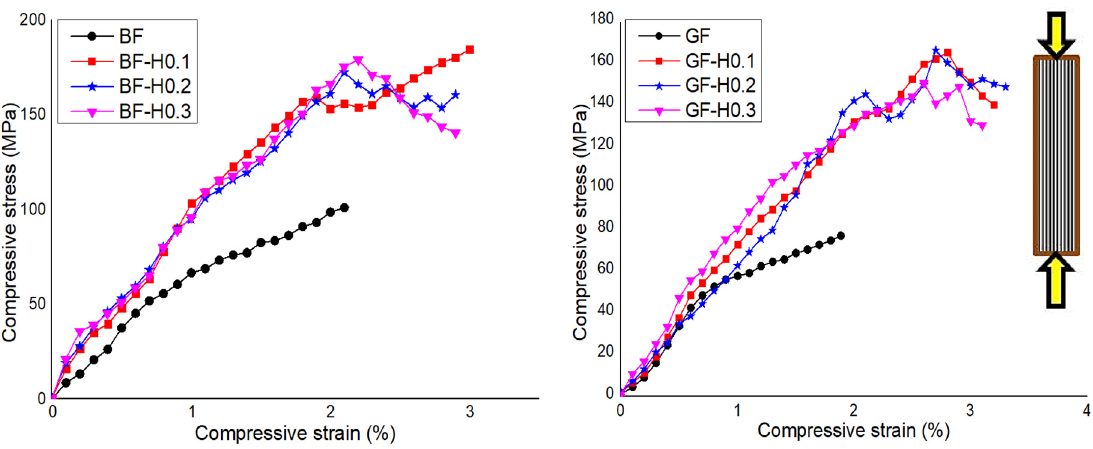
Figure 4. SEM micrographs showing the tensile damage specimens of ( a ) unmodified BF and ( b ) BF-H0.1 composites.